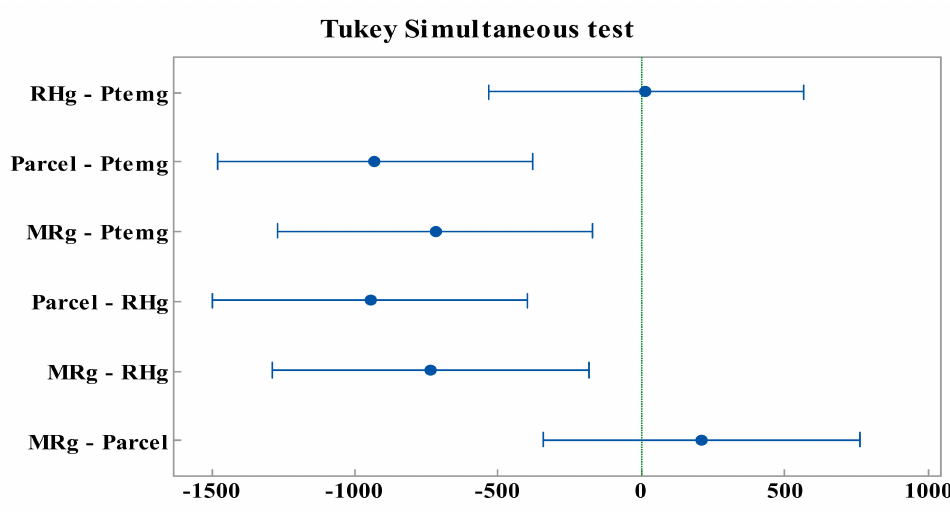
Figure A2. Tukey’s simultaneous test for di ff erence of the mean ABLH estimated using di ff erent methods. Results are reported at 95% confidence level. For pairs where the interval does not possess a zero, the di ff erence is statistically